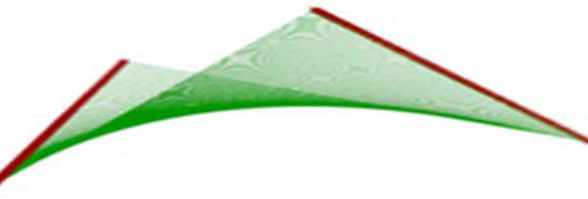
Figure 3. A hyperbolic paraboloid with the directrix lines expressed.